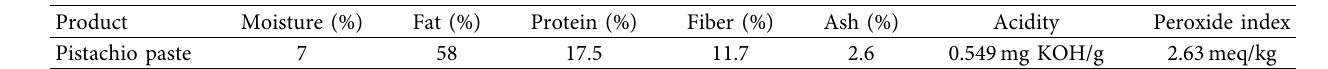
Table 3: Chemical properties of pistachio paste.